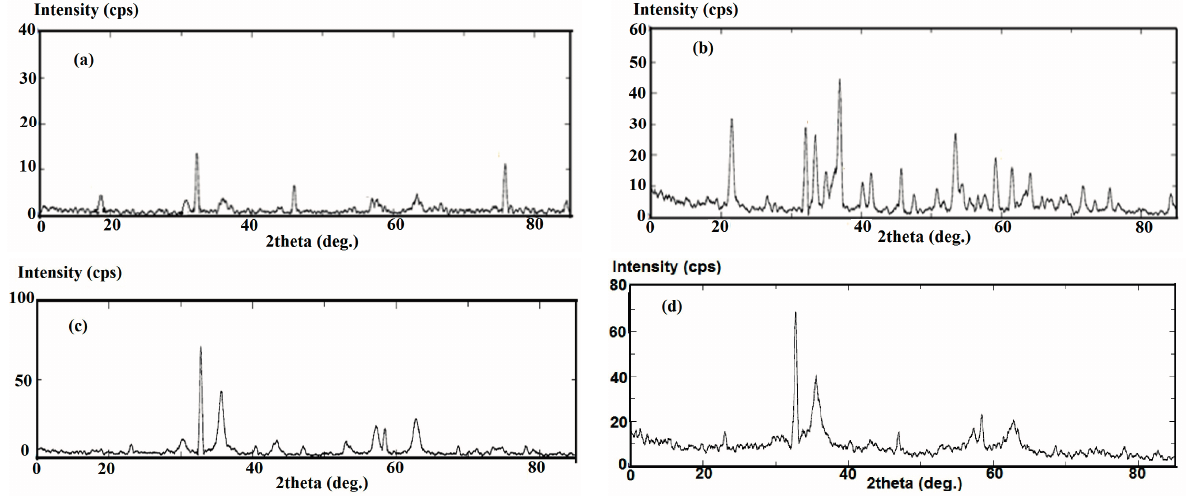
Figure 2. XRD diffractograms of the prepared magnetite ( a ) absence of iodine; ( b ) presence of iodine; ( c ) presence of myrrh; and ( d ) presence of myrrh and